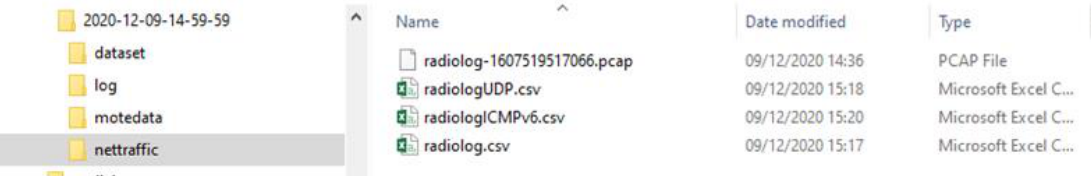
Figure 32. The “nettraffic” folder inside the root folder “2020 -12-09-14-59- 59” and the copy of the “radi olog- 1607519517066.p cap” file . Figure 33. The “nettraffic” folder inside the root folder “2020 -12-09-14-59- 59” and its included files .